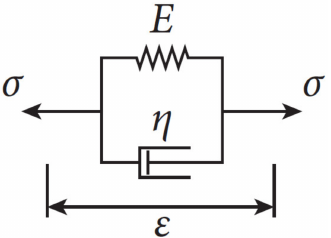
Figure 2. Representation of unidimensional Kelvin–Voigt